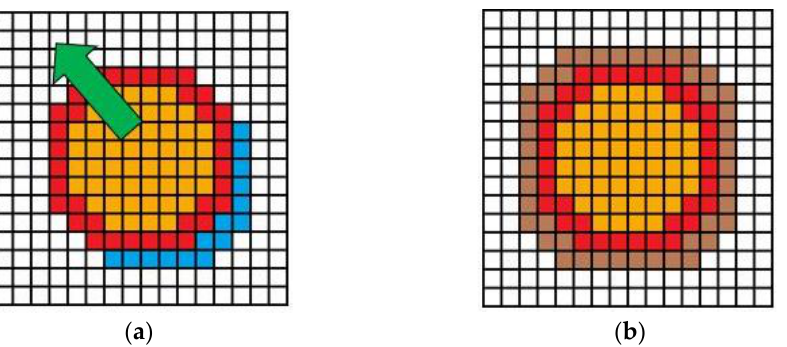
Figure 3. LBM coupling scheme with particle (orange), particle boundary (red) and fluid (white) nodes. ( a ) New fluid nodes (blue) after particle movement, ( b ) surrounding layer of fluid nodes (brown) used to compute viscous and pressure forces which act on the particle.